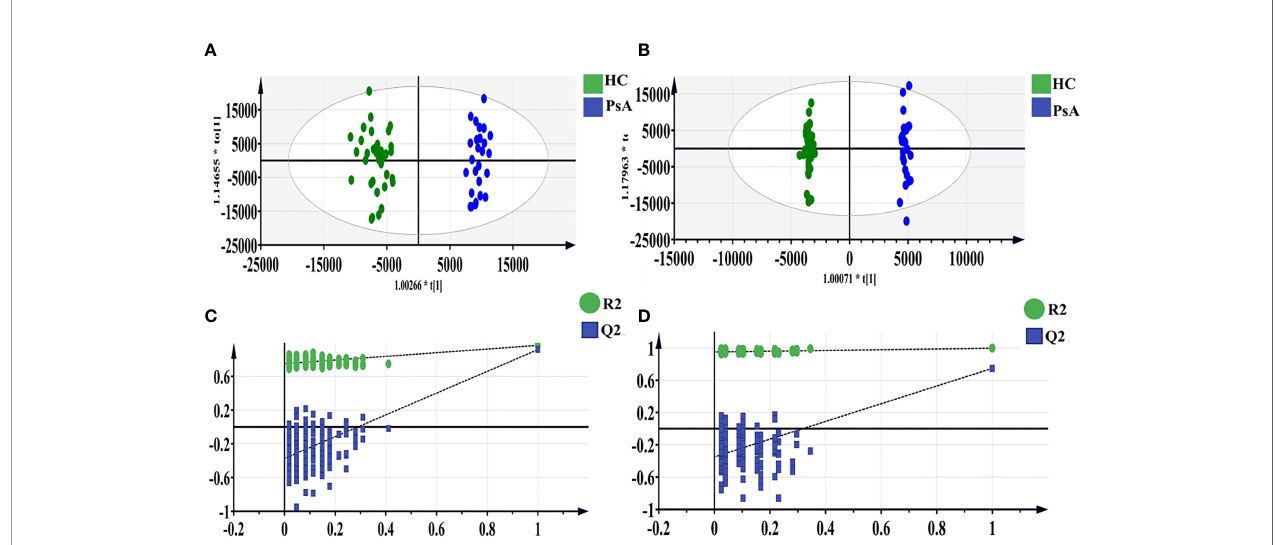
FIGURE 2 | OPLS-DA score scatter plots of polar extracts between HC group and PsA group in positive (A) and negative ion mode (B) . The result of permutation test in positive ion mode (C) and negative ion mode (D) . The R 2 and Q 2 values were R 2 X (cum) = 0.317, R 2 Y (cum) = 0.968, Q 2 (cum) = 0.918 in positive mode. The R 2 and Q 2 values were R 2 X (cum) = 0.362, R 2 Y (cum) = 0.997, Q 2 (cum) = 0.748 in negative mode. The intercept of Q 2 of positive and negative ion modes on the y-axis was <0, indicating a valid